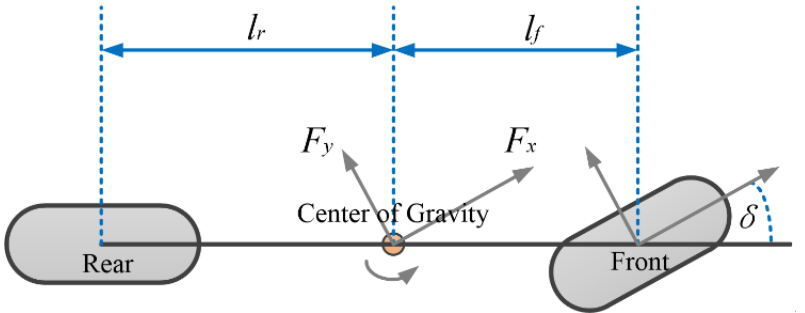
Figure 1. Vehicle dynamics model.